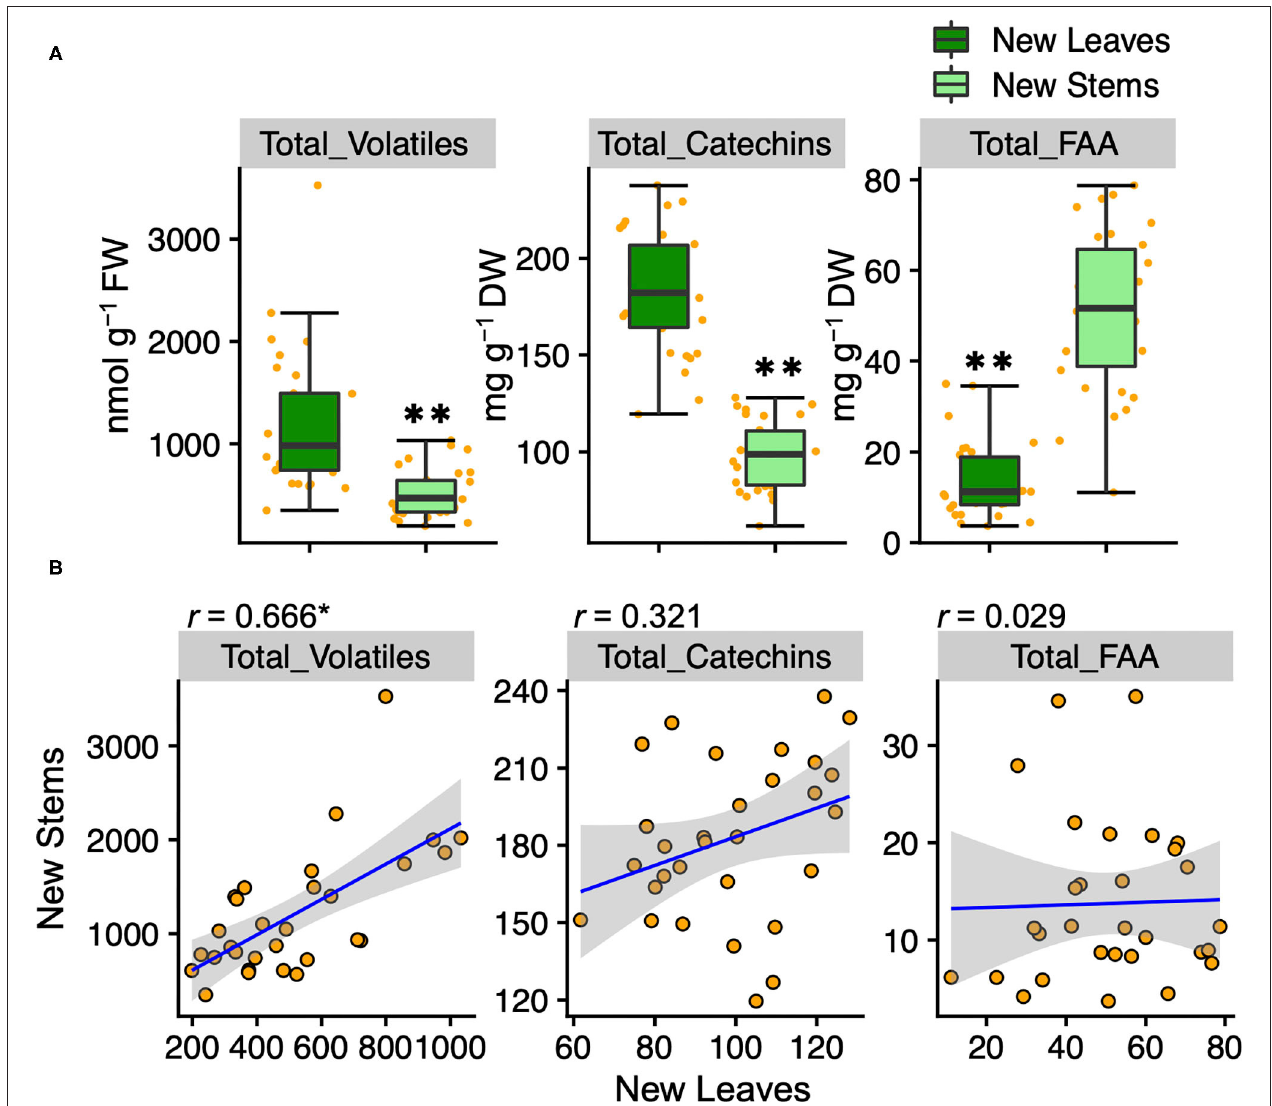
FIGURE 2 | Boxplots (A) and correlations (B) of total volatiles, catechins, and amino acids contents in new leaves and stems of the tea accessions, respectively. Orange plots indicate the values of each accession. Double asterisks in (A) indicate P < 0.01 (Welch’s t -test). Asterisk in (B) indicates P < 0.01 (test of no correlation).